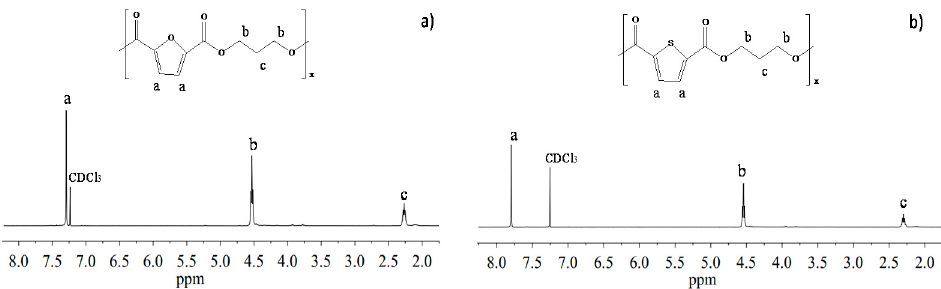
Figure 3. 1 H-NMR spectrum of: ( a ) PPF; ( b ) PPTF with resonance assignments. Table 1. Molecular, thermal and mechanical characterization data for PPF and PPTF.